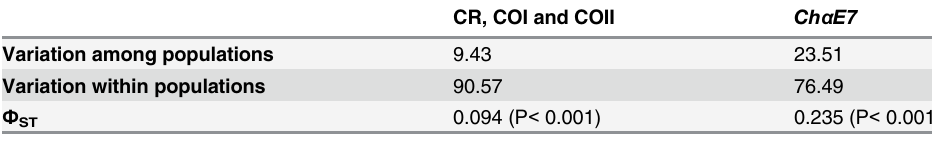
Variation among